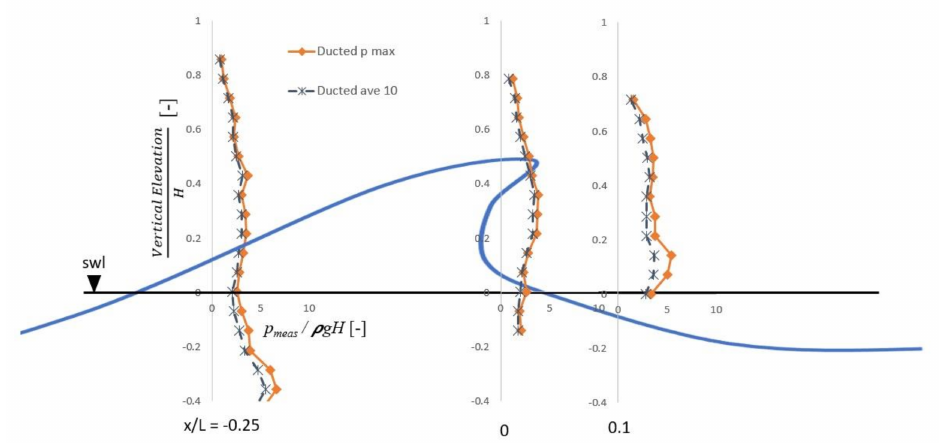
Figure 13. Pressure measurements at various elevations and horizontal locations for the ducted case for both the maximum pressure (orange line diamond) and average of the 10 highest wave impact pressures (dashed grey asterisk). The simplified breaking wave image on the background is intended as a visual aid only and does not represent the actual breaking wave during